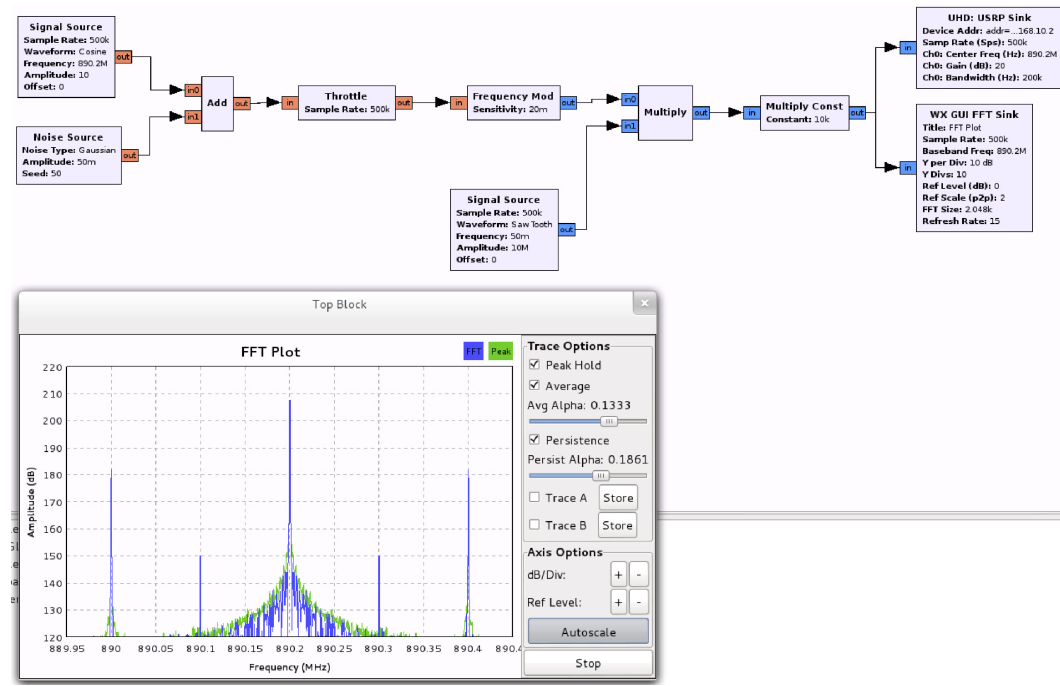
Figure 8. Jammer building